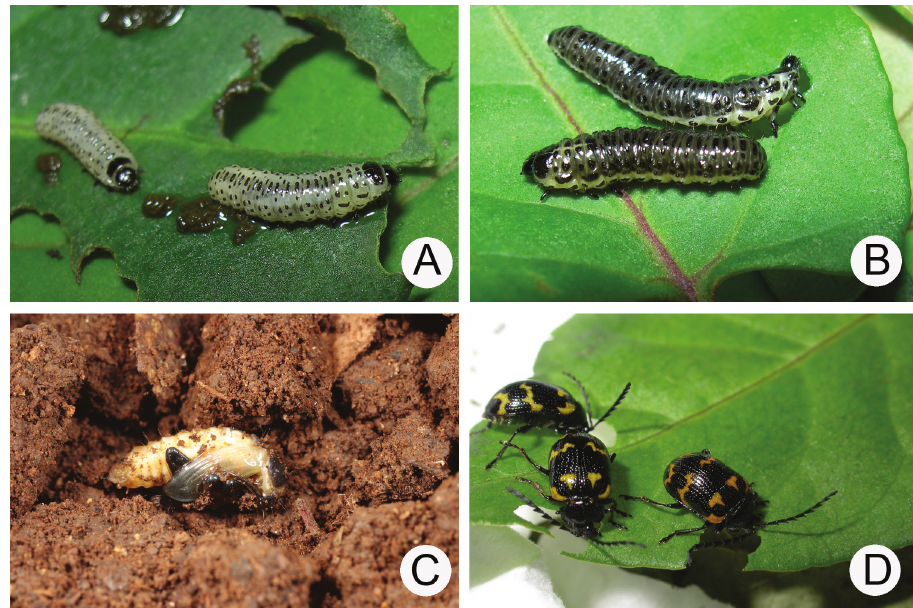
Figures 3. Field photographs of Gallerucida bifasciata Motschulsky. A Early instar larvae B Mature larvae C Pupa D